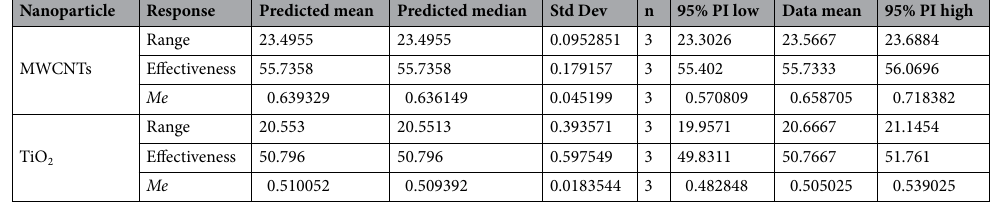
Table 17. Optimal point